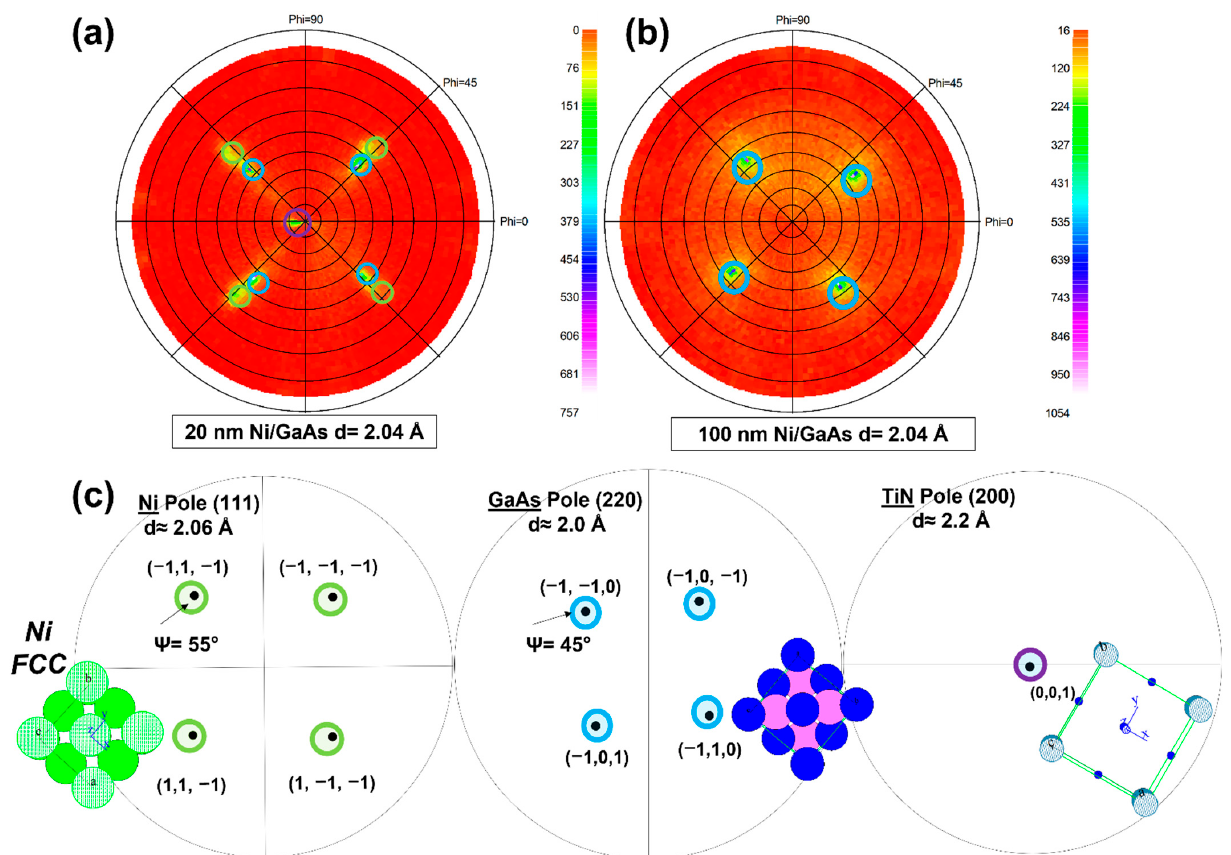
Figure 2. Experimental pole figure around the Ni (111) position at d = 2.04 Å for ( a ) 20-nm-thick Ni and ( b ) 100-nm-thick Ni samples after deposition on GaAs and ( c ) simulation of the pole figures of: Ni FCC, TiN, and GaAs substrate.